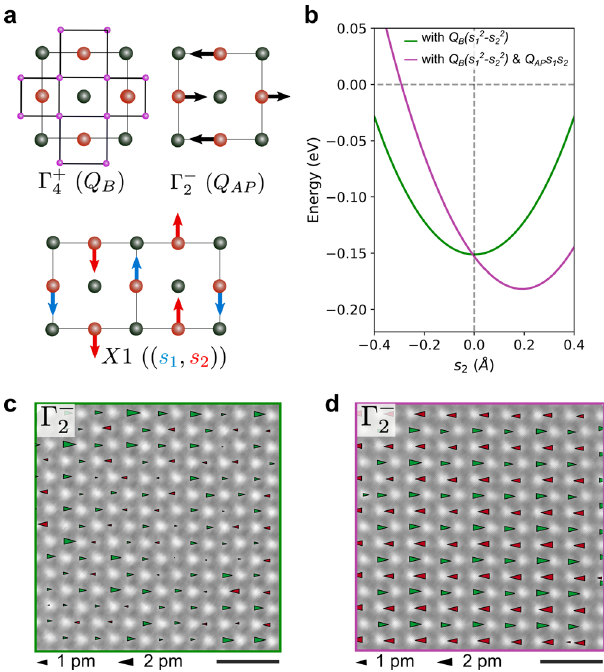
Fig. 4 Nonlinear lattice coupling determines the charge-order ground mode (oxygen breathing state. a Displacement patterns for the Γ þ 4 distortion), the Γ (cid:3) mode (Mn antipolar displacement), and the X1 mode. 2 The purple dots represent the oxygen atoms. b One-dimensional plot of the full Landau free energy (Eq. (3) in Supplementary Information section 5) as a function of the amplitude of s 2 . The linecut is taken along the (0, s 2 ) axis and through the s 1 value that minimizes the energy. When the fi rst coupling term is included and the second term is suppressed (green) the minimum energy is located at ( s 1 ≠ 0, s 2 = 0) indicating that site-centered order is favorable. If both coupling terms are present (magenta) both s 1 and s 2 are fi nite but not equal indicating that intermediate order is favorable. The values for the coef fi cients in the Landau free energy and the Q B / Q AP amplitudes are listed in the Supplementary Information section 5. The amplitude of s 2 (in Å ) is with respect to a 40-atom DFT supercell. Mn displacements in the site-centered c , d Atomic-scale maps of the Γ (cid:3) 2 and intermediate region, respectively. The largest arrows correspond to ~2 pm. The displacements are disordered in the former and coherent in the latter, in agreement with the Landau theory predicting that the Γ (cid:3) mode 2 favors X1 displacements on both sublattices. Both scale bars correspond to